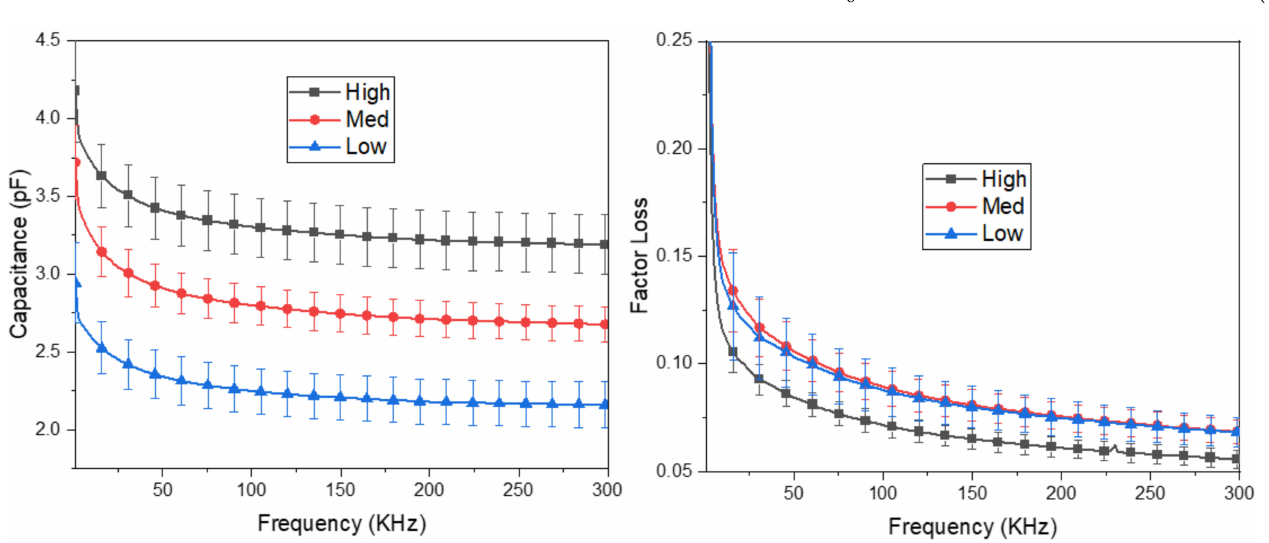
Figure 8. Frequency dispersion of capacitance and loss tangent of initial sensors (low, medium, high density).